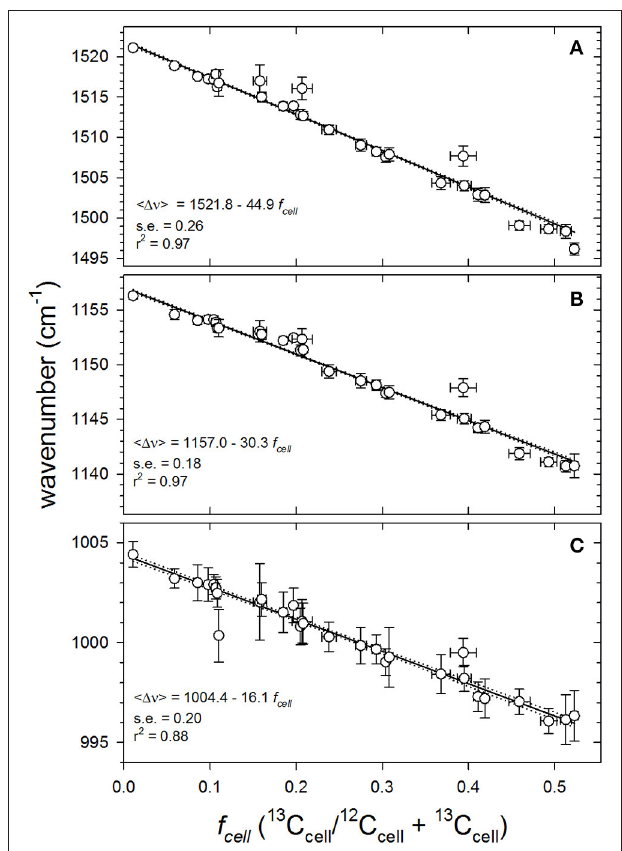
FIGURE 5 | Quantitative responses of mean SCRR wavenumbers h 1 ˜ ν i of the three dominant carotenoid peaks to varying cellular fractional labeling ( f cell ) for all f media (0.011–0.54) throughout exponential growth phase (0–18 days). Symbols and vertical error bars represent mean SCRR wavenumber observations ± 1 S.D., respectively. Horizontal error bars represent uncertainties propagated in calculating f cell ( see SM 3 ). Solid lines are empirical least squares linear regressions through individual data points ( N = 836 cells). Dotted lines define the 99% confidence intervals of each slope ( b 1 ); (A) ν (C = C), (B) ν (C-C), and (C) δ (C =